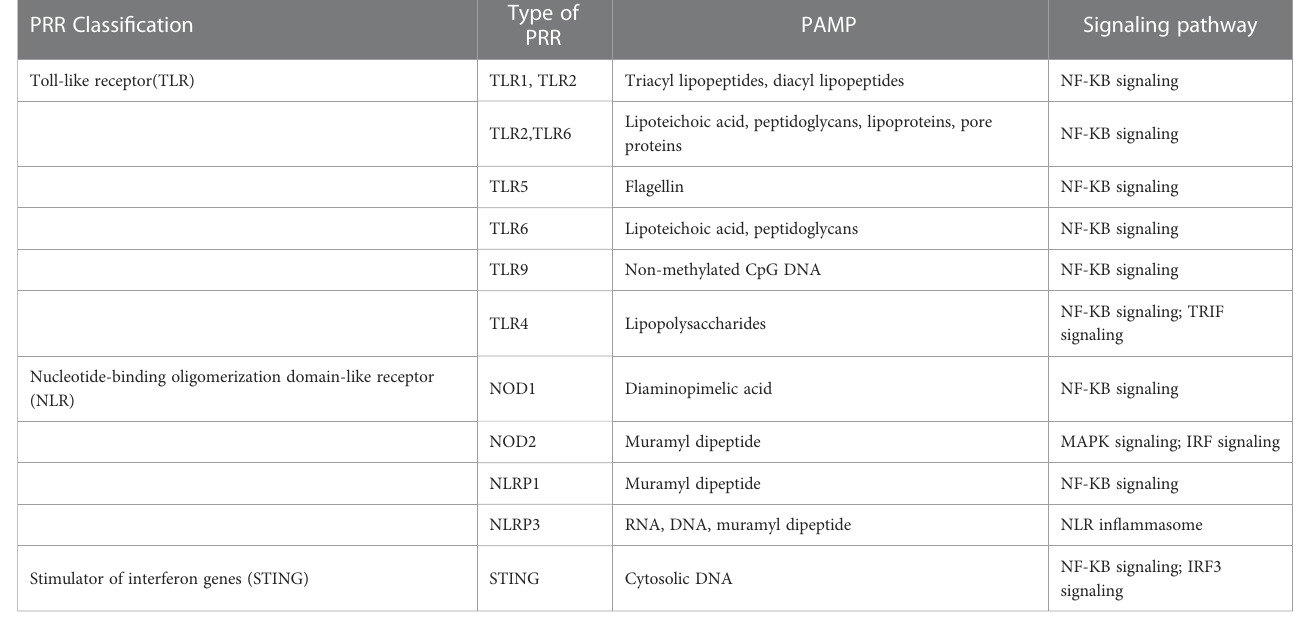
TABLE 2 Bacterial PRRs, PAMPs, and their corresponding signaling